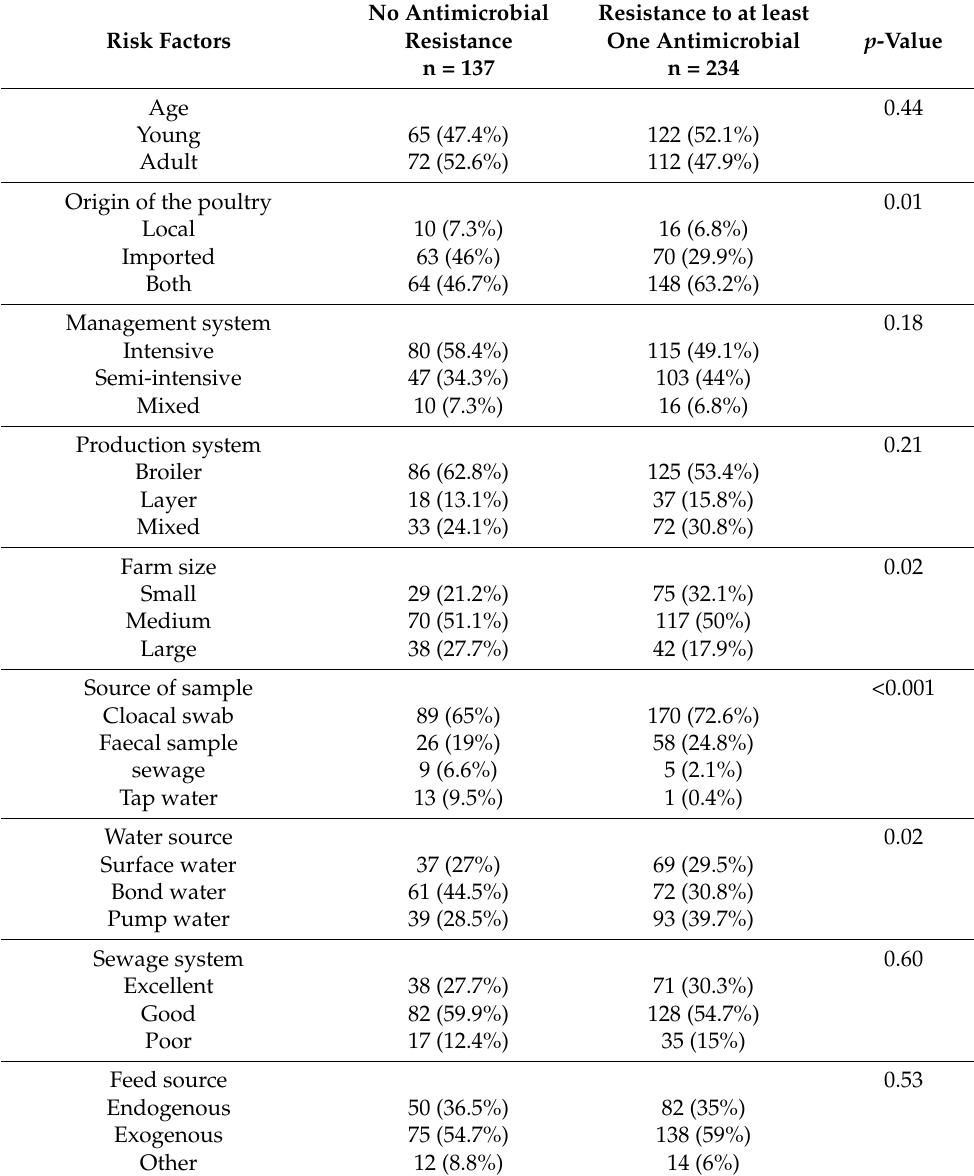
Table 2. Summary of prevalence of resistance to at least one antimicrobial and their associated risk